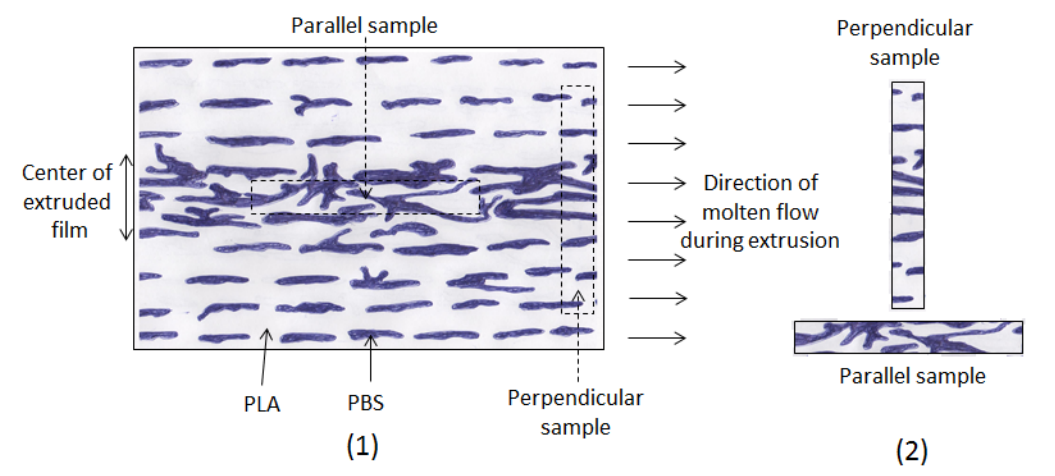
Figure 4. Molten film of PLA/PBS blend during extrusion ( 1 ); perpendicular and parallel samples ( 2